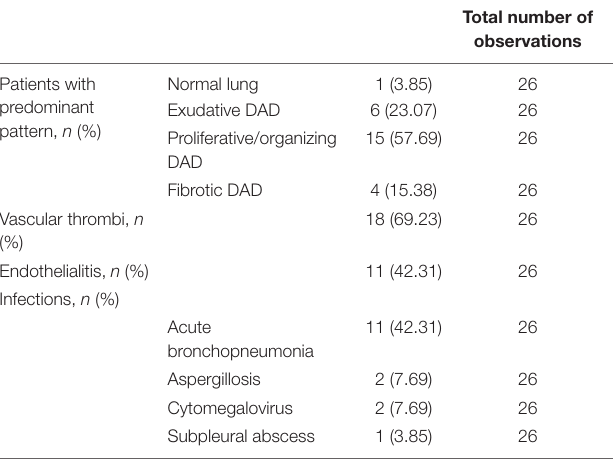
TABLE 2 | Lung pathological